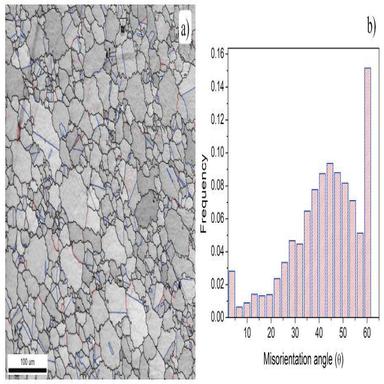
a) EBSD image quality map superimposed with HAGBs (solid black line), LAGBs (solid red line) and twin boundaries (solid blue line) b) Misorientation angle distribution. (For interpretation of the references to colour in this figure legend, the reader is referred to the Web version of this article.)